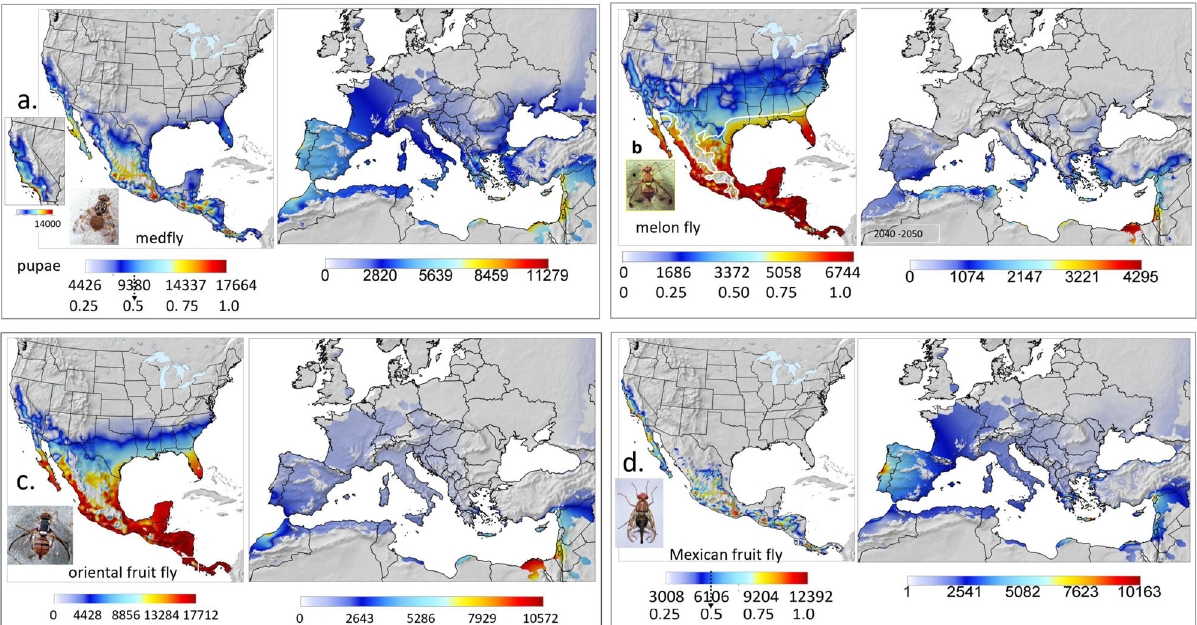
Fig. 4 Prospective average distribution and relative abundance (average annual sum of pupae) under climate change. a Mediterranean fruit fl y, b melon fl y with the FI = 0.5 isocline indicated in white, c oriental fruit fl y and d Mexican fruit fl y in North and Central America (2055 – 2065), and in the European- Mediterranean region (2040 – 2050) (detailed maps in Supplementary Figs. S7 – S10). Clips of the tropical fruit fl ies are by Jack Kelly Clark, University of California Statewide IPM